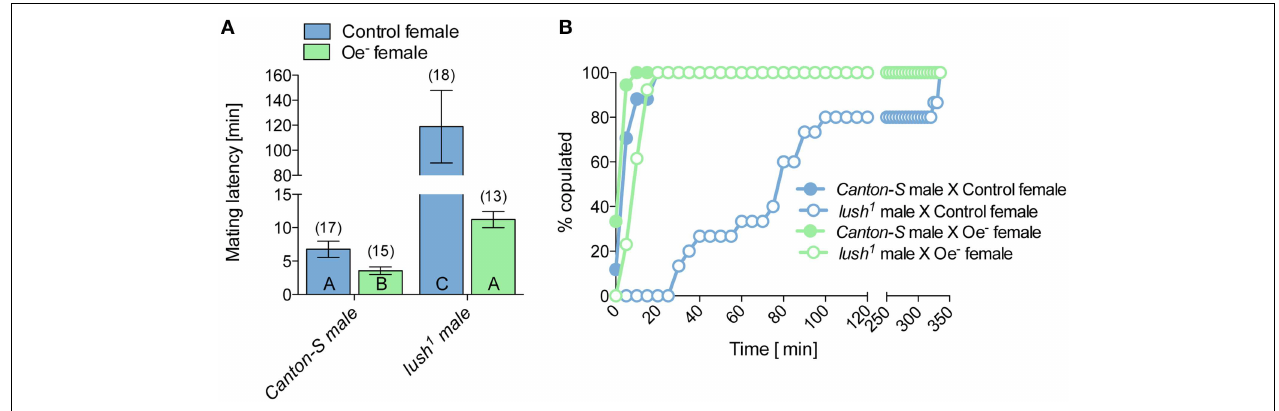
other as determined by a One-Way ANOVA [ANOVA F (3 , 59) = 74 . 4 ; P < 0 . 0001 ] followed by Tukey post-hoc test. (B) Cumulative percentage of pairs of virgin male and female of the indicated genotypes. Data is same as in (A) but plotted as cumulative mating to illustrate when most copulations take